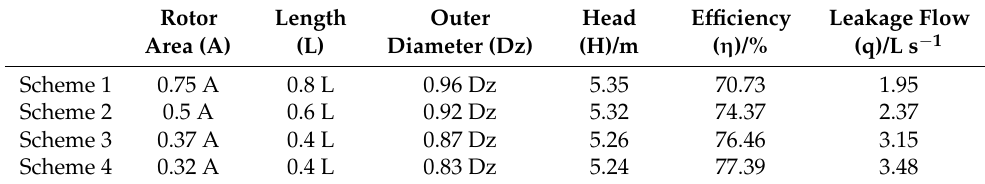
Table 3. The summary of prediction results.